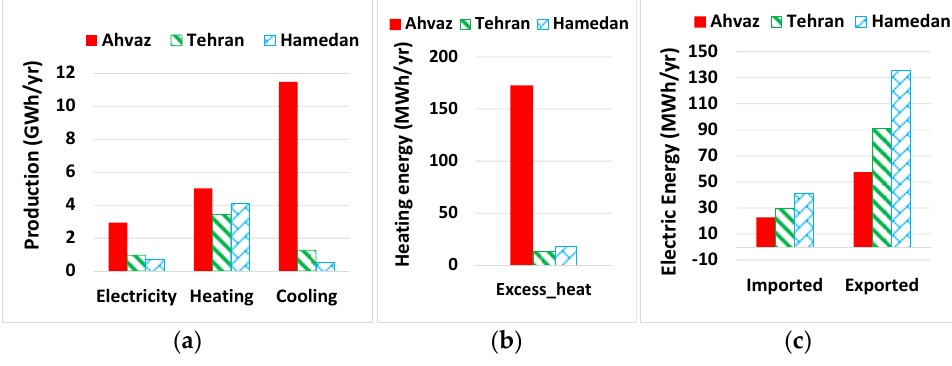
Figure 9. Yearly production ( a ); excess heat ( b ) and imported/exported power ( c ).